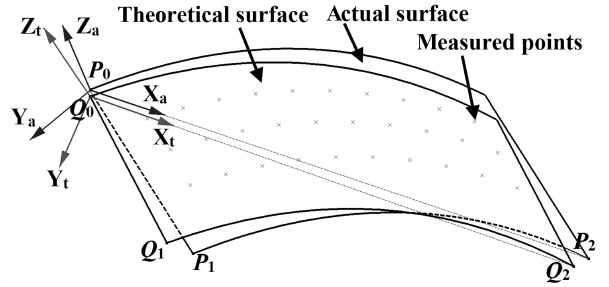
Figure 2. The local coordinate